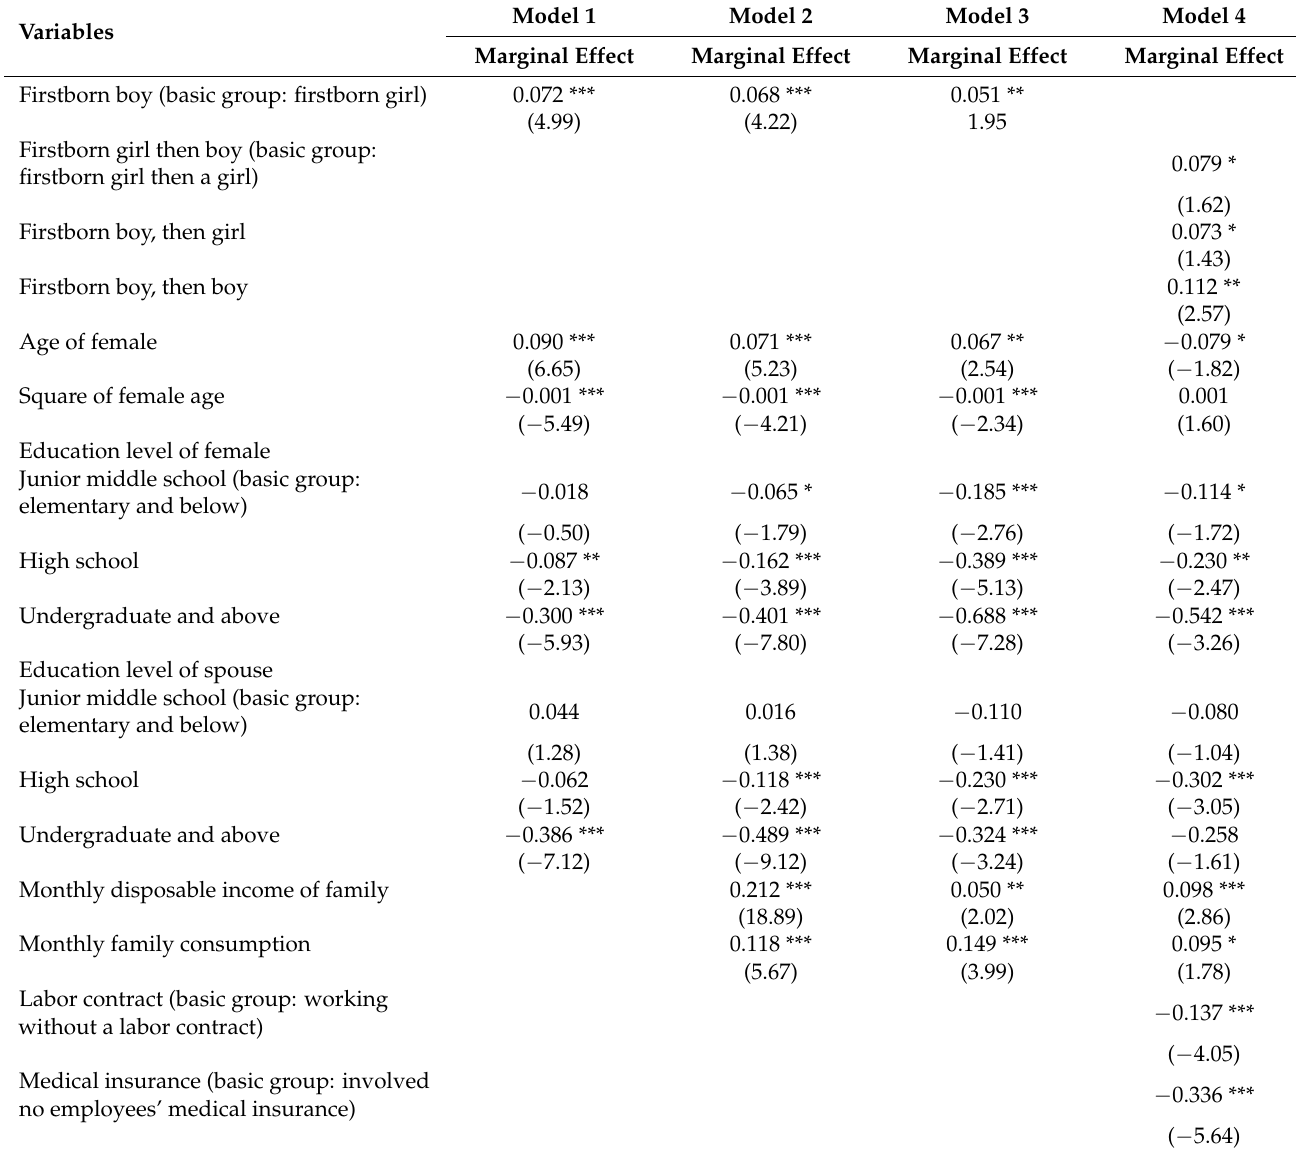
Table 2. Having sons and migrant women’s overtime